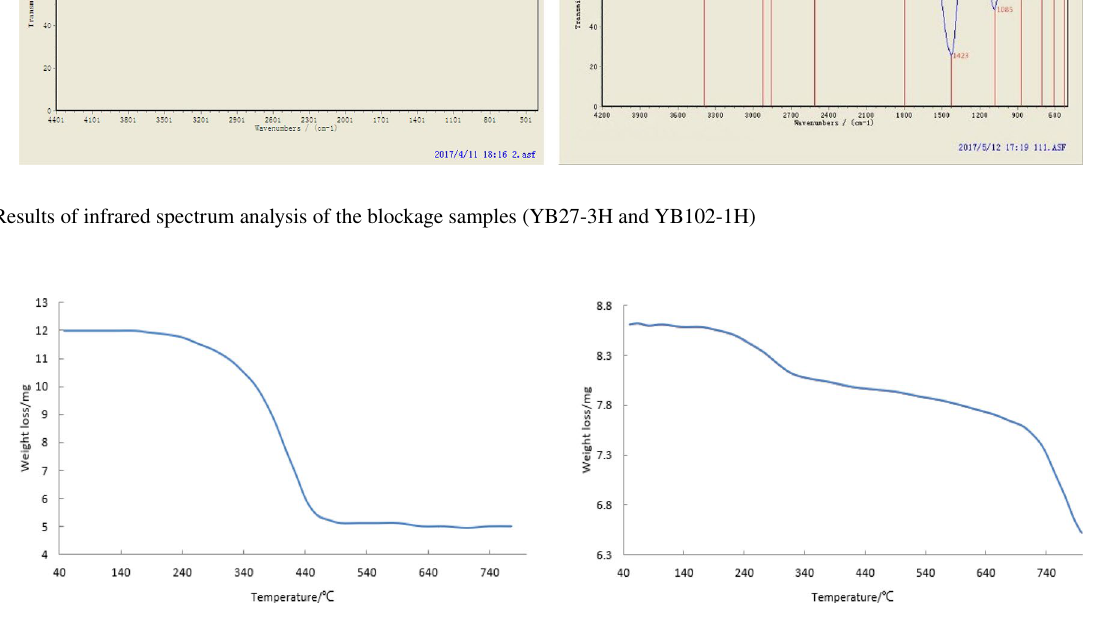
Fig. 6 Relation curve between the temperature and the weight loss of samples of YB27-3H and